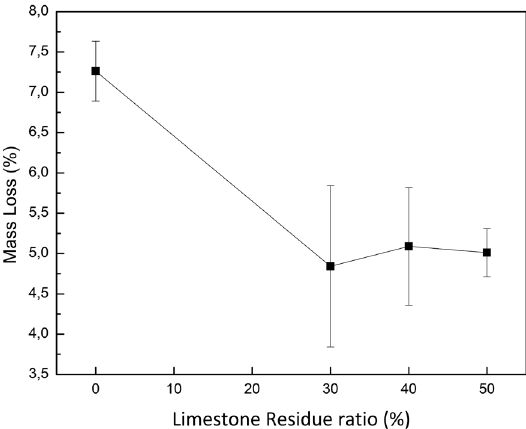
Figure 6. Mass loss obtained by wettability and drying results